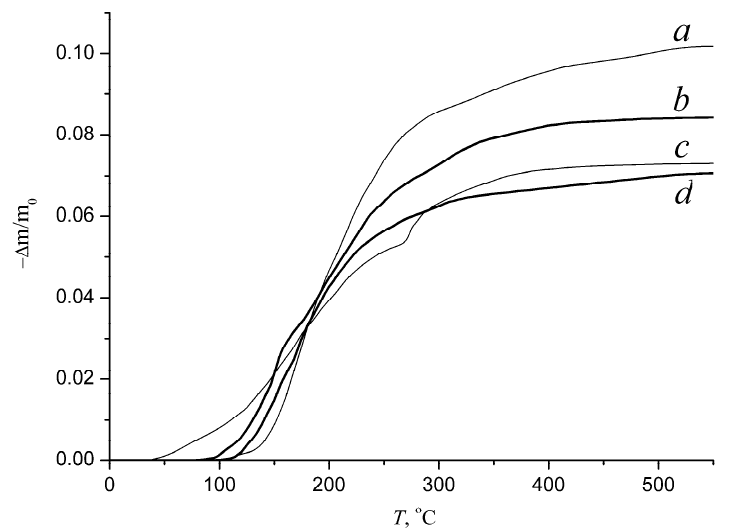
Figure 3. Thermogravimetric curves for ( a ) initial low-temperature elpidite from Lovozero, ( b ) initial rock-forming elpidite from Khan Bogdo, ( c ) Ag-exchanged elpidite from Khan Bogdo (Sample II ) and ( d ) Ag-exchanged elpidite from Lovozero (Sample I ).